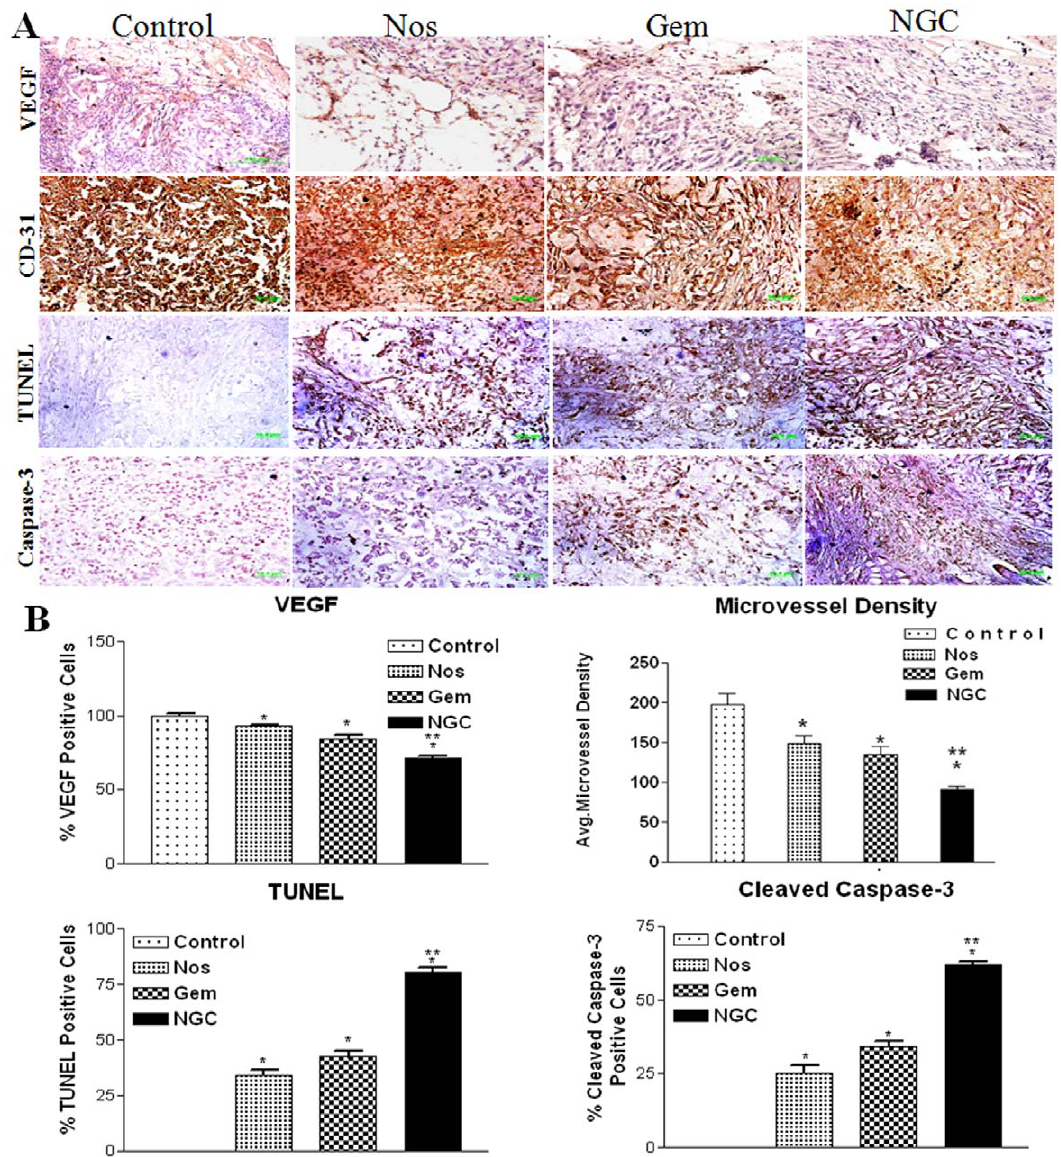
Figure 6. Immunohistochemical staining of H460 tumor tissues for VEGF, CD31, TUNEL assay and cleaved caspase 3 expression (A) and (B) quantitation of quantization of VEGF, assessment of microvessel density, quantitation of TUNEL positive cells and cleaved caspase 3 positive cells. Data are expressed as mean + SD (N=6).